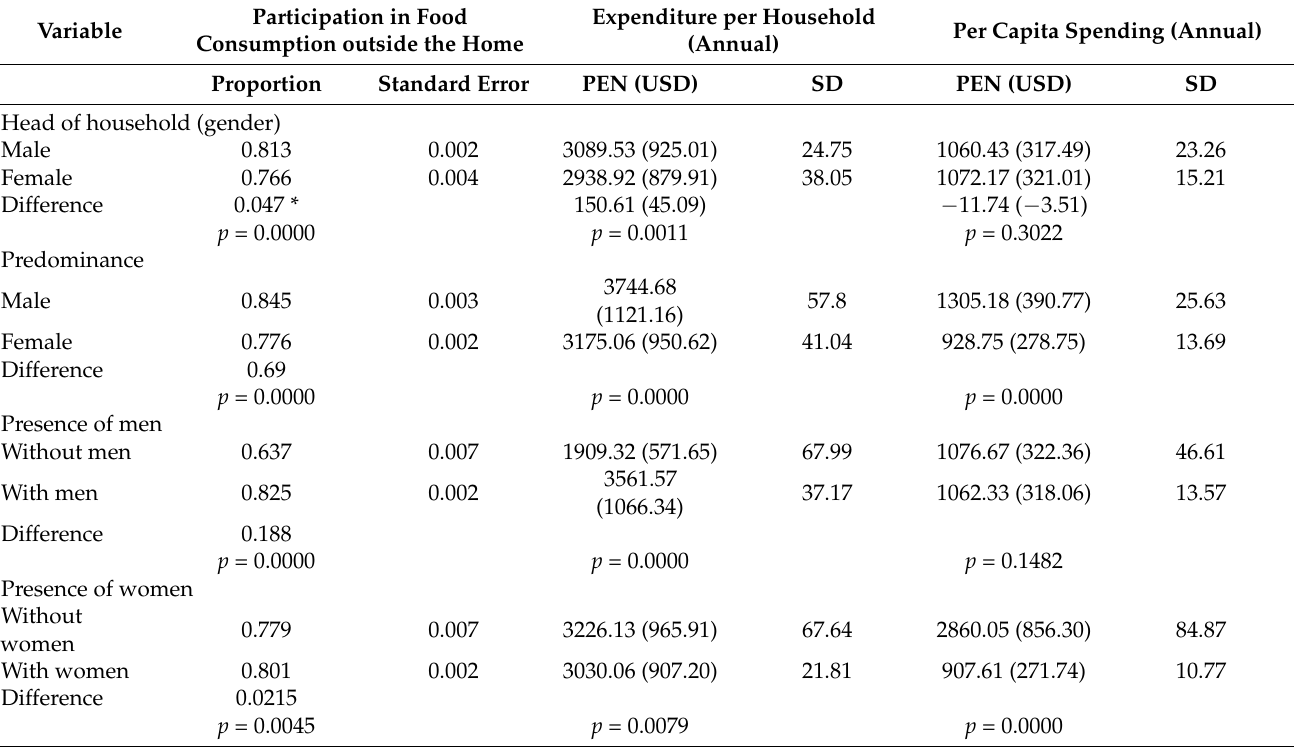
Table 1. Participation of the head of household in food consumption away from home and household expenditure and per capita expenditure, ENAHO 2019.